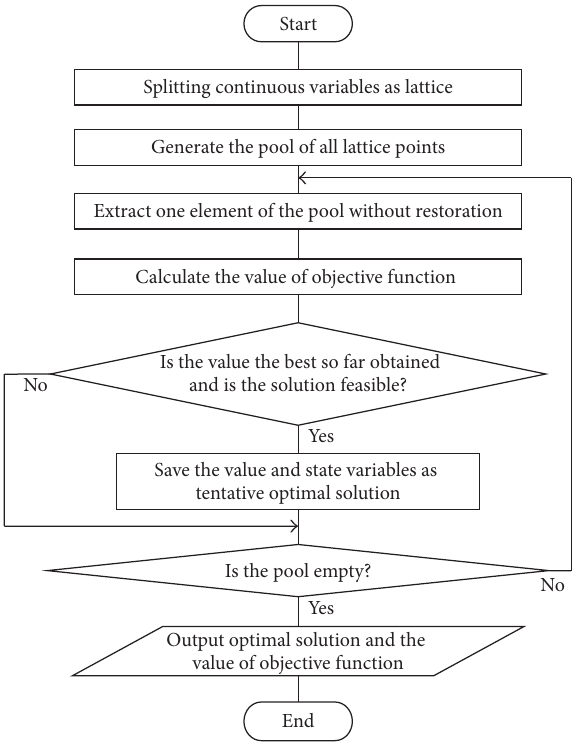
Figure 2: Flowchart of CFE